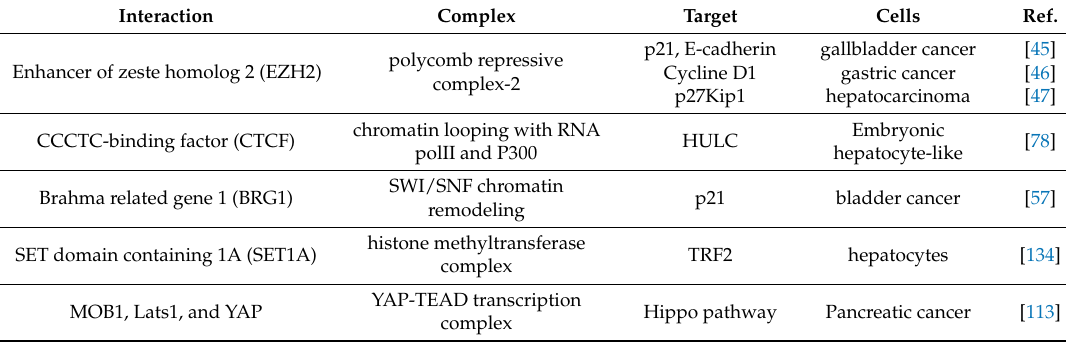
Table 3. The interaction of UCA1 with transcription regulating